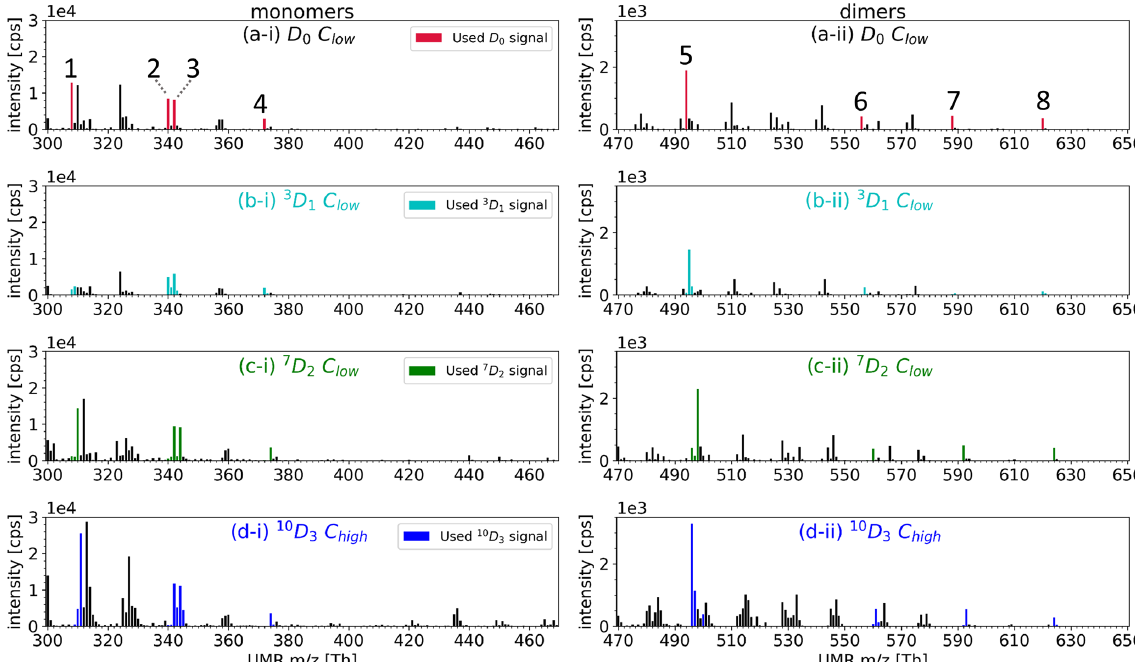
Figure A2. Mass spectra of HOMs from selectively deuterated α -pinene precursors at unit mass resolution. Masses corresponding to HOM signals used on closer inspection are marked with a colour, whereas other peaks in the mass spectra are shown in black. (a-i) and (a-ii) : the closer-inspection compounds are 1. C 10 H 14 O 7 , 2. C 10 H 14 O 9 , 3. C 10 H 16 O 9 , 4. C 10 H 14 O 11 , 5. C 19 H 28 O 11 , 6. C 20 H 30 O 14 , 7. C 20 H 30 O 16 , and 8. C 20 H 30 O 18 . The y scales are different between the monomer and dimer plots.